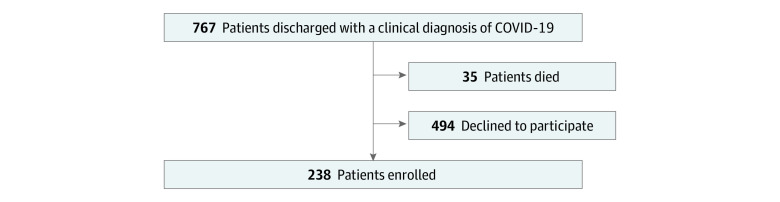
Flowchart of the Study PopulationCOVID-19 indicate coronavirus disease 2019.